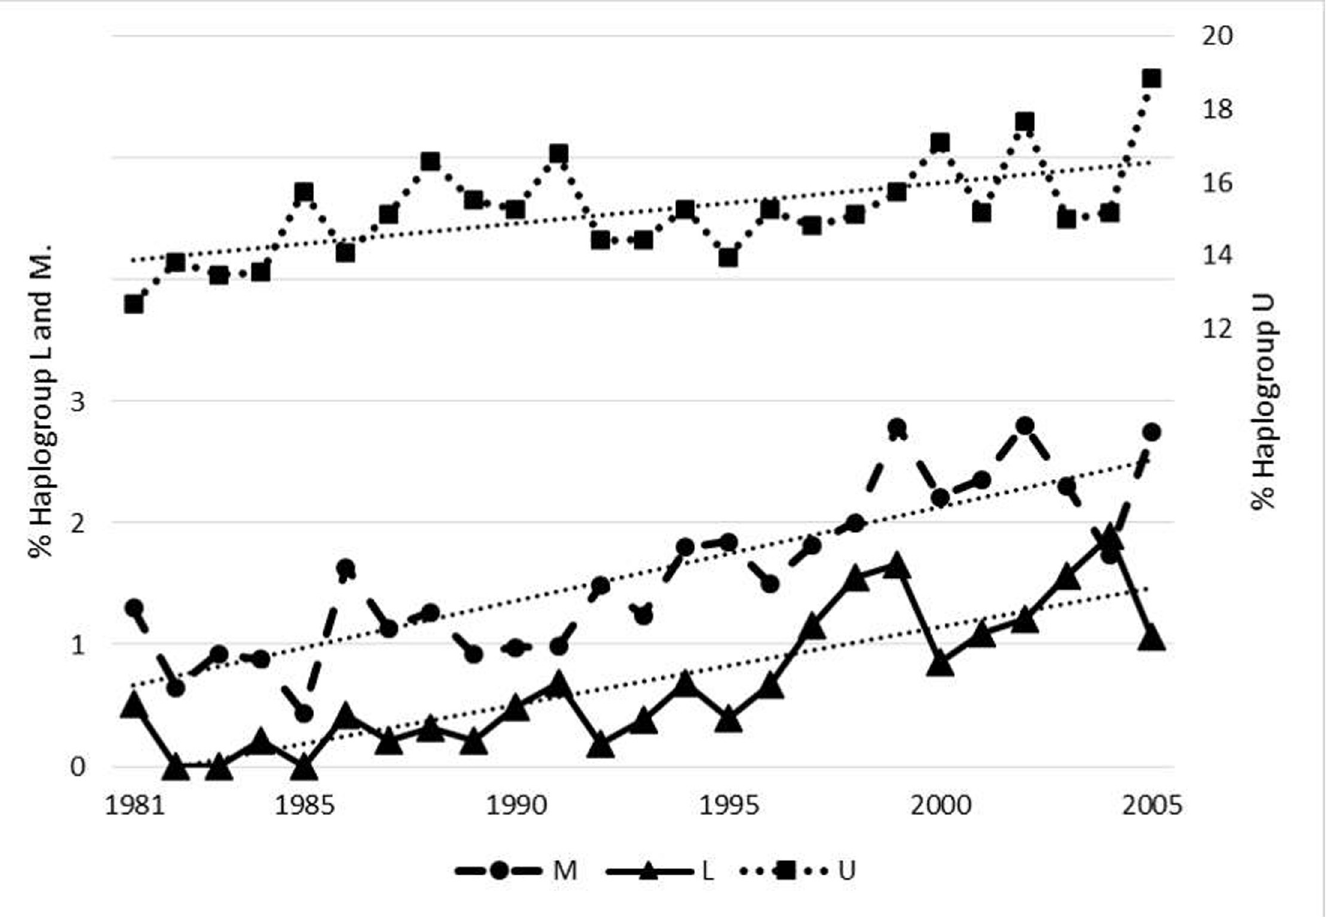
Fig 7. The proportion of haplogroup L, M and U as a function of birth